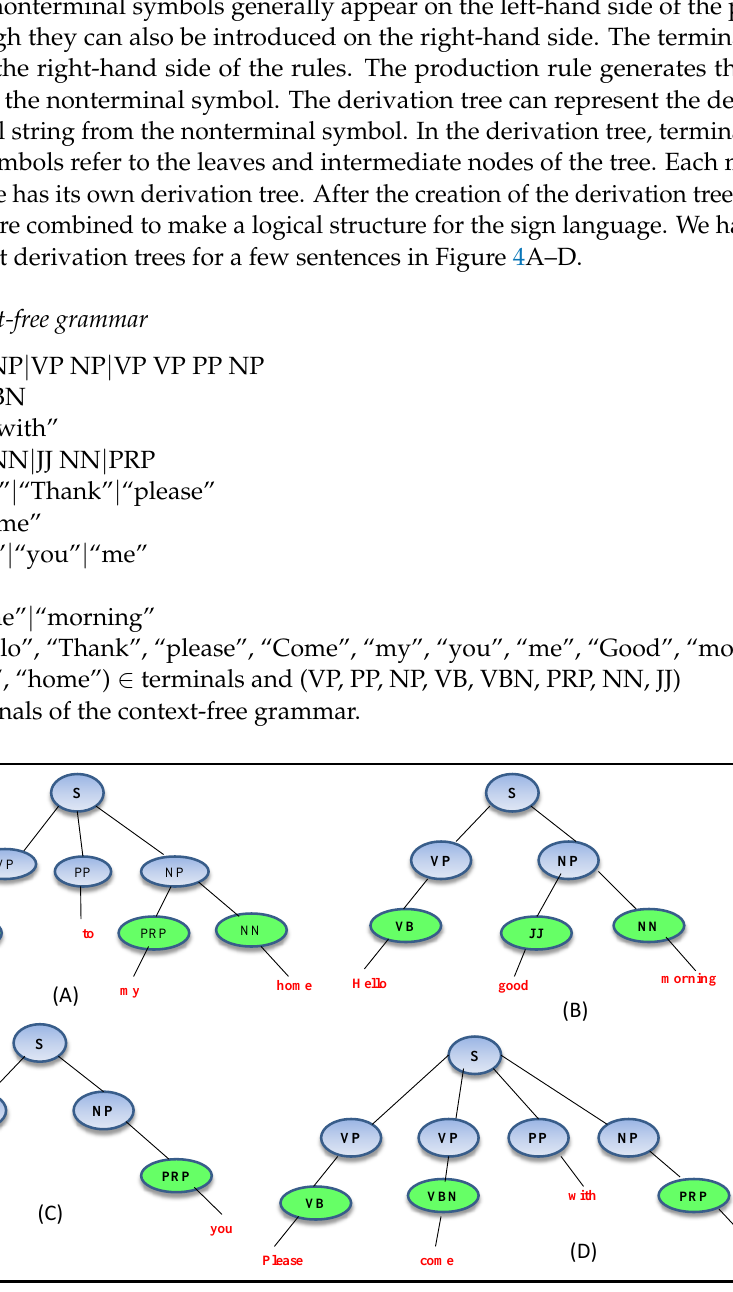
Figure 4. Derivation tree for the sentences: ( A ) Come to my home, ( B ) Hello good morning, ( C ) Thank you, ( D ) Please come with me. Note: terminal symbols are represented in red, whereas green and blue refer to the nonterminal symbols of the derivation tree (generated from the above CFG). The start symbol (often represented as S) is a special nonterminal symbol of the